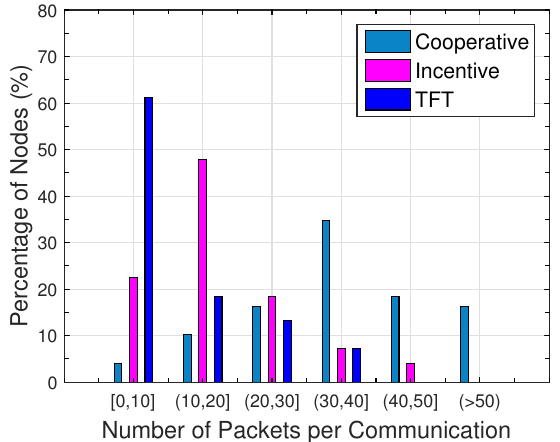
Figure 4. Distribution of the packet exchange.